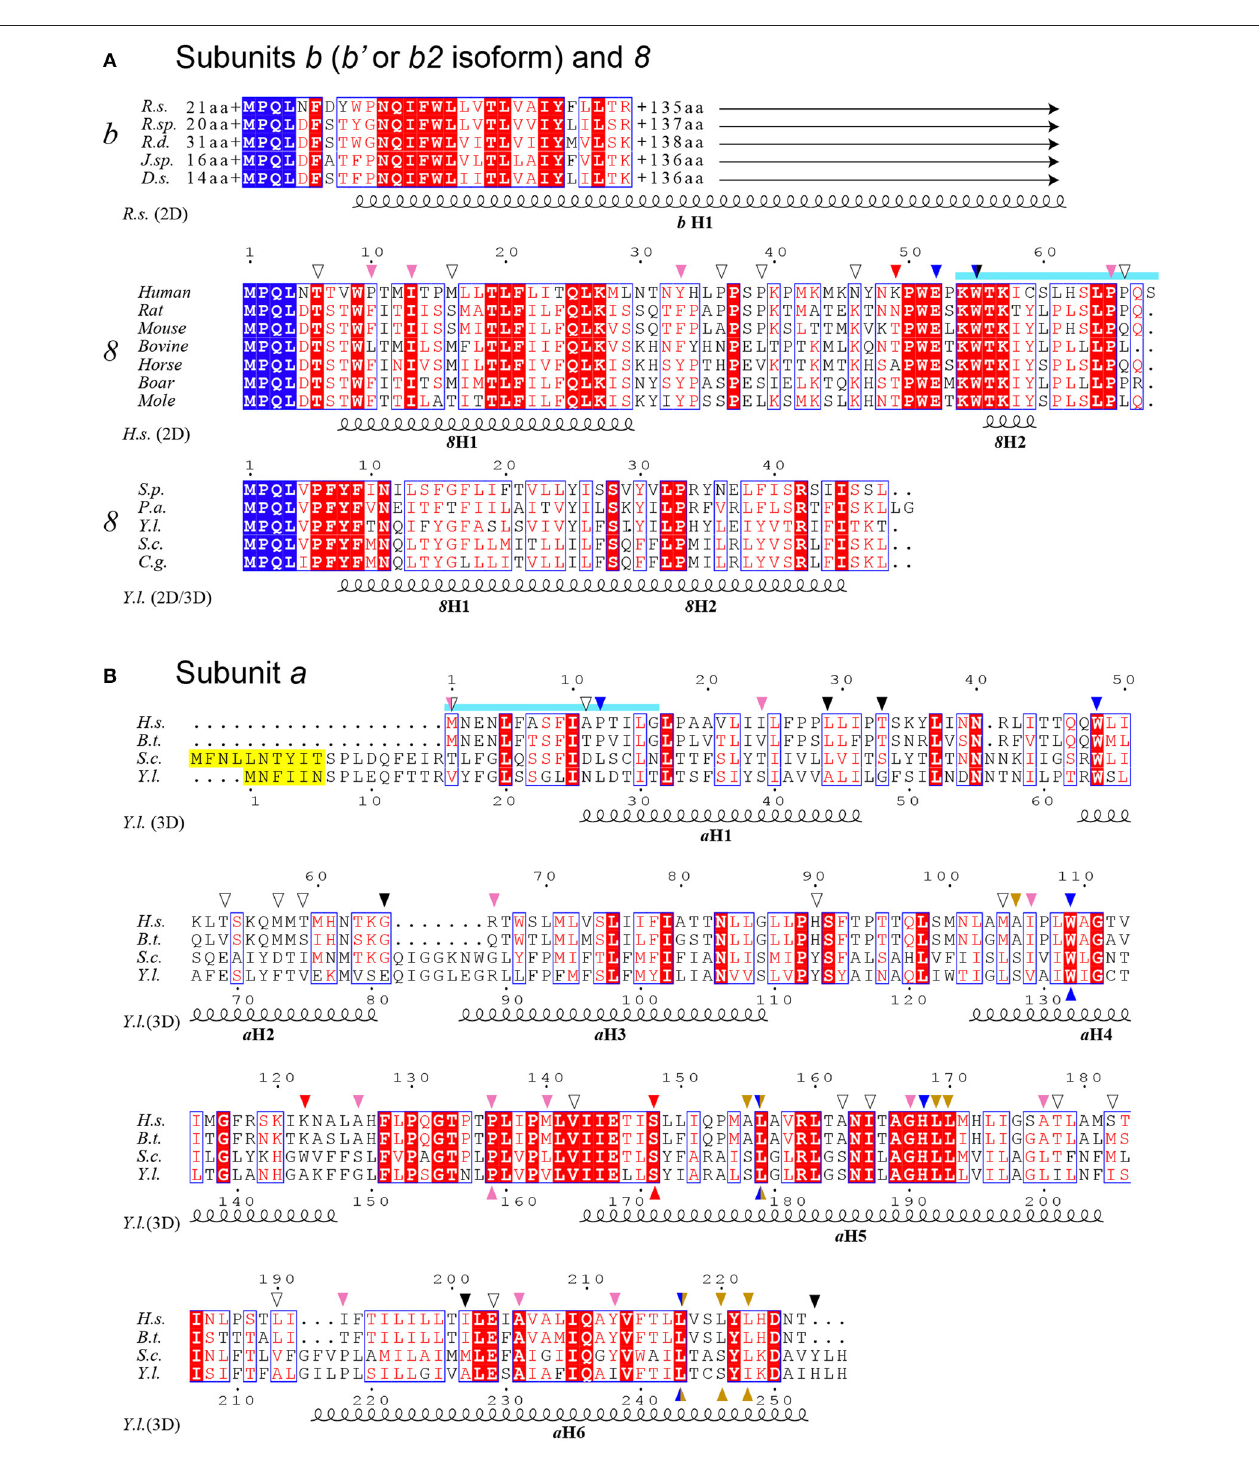
FIGURE 3 | Sequence alignment of subunits a , b and 8 from a selected range of species. (A) Alignment of bacterial subunits b ( b ′ or b2 isoform) and mitochondrial subunits 8 . The sequences of subunit b are from Rhodobacter sphaeroides ( R.s. ) , Ruegeria sp. ( R.sp ) , Roseobacter denitrificans ( R.d. ), Jannaschia sp. ( J.sp ) and Dinoroseobacter shibae ( D.s .). The length of N- and C-termini extensions are given. The sequences of subunit 8 are from a selection of mammals and the yeast species Schizosaccharomyces pombe (S.p.), Podospora anserina (P.a.), Yarrowia lipolytica ( Y.l. ) , Saccharomyces cerevisiae ( S.c. ) and Candida glabrata ( C.g. ). (B) Alignment of subunit a . Homo sapiens (H.s.), Bos taurus ( B.t. ). The sequences corresponding to overlapping ATP8 and ATP6 genes are marked in cyan as in